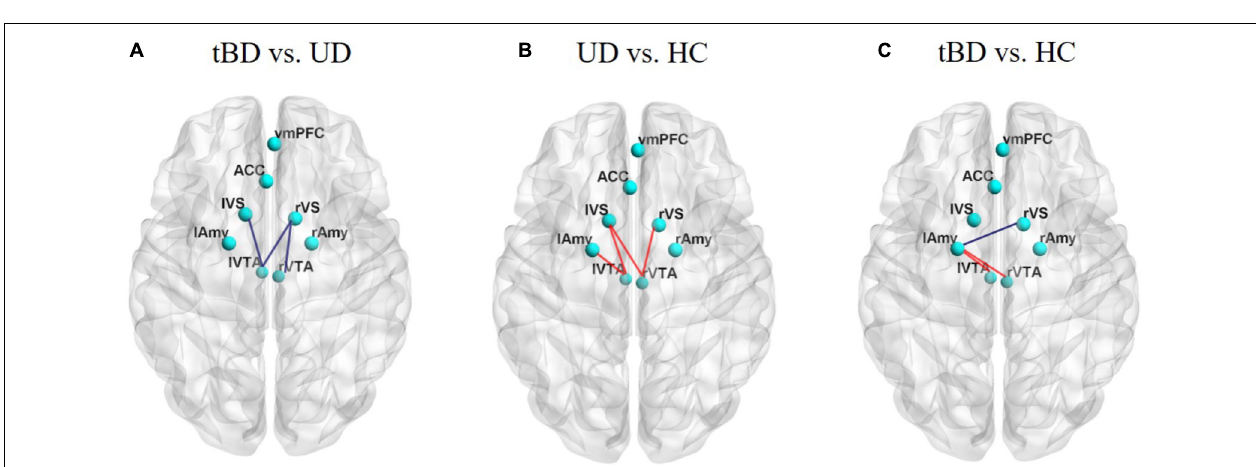
FIGURE 1 | Left VTA and left VS rsFC difference between tBD, UD, and HC. ∗ P < 0.05, uncorrected; ∗∗ P < 0.05, FDR